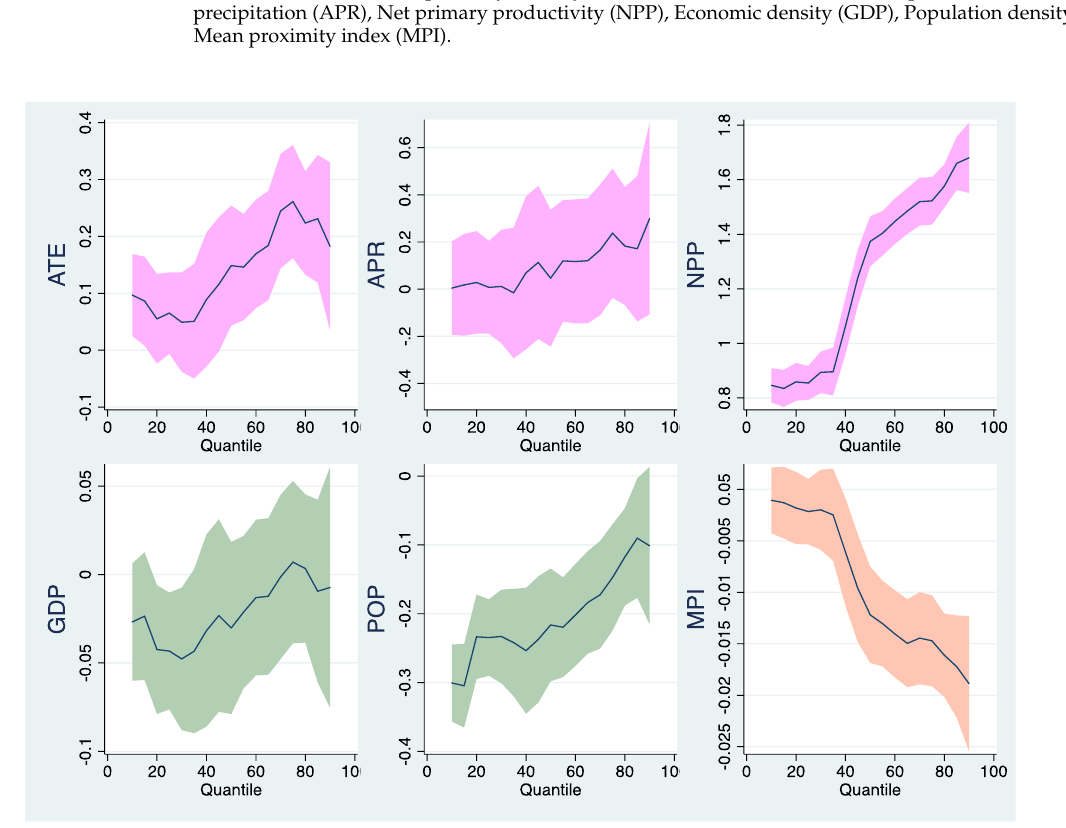
Figure 7. Quantile regression coefficient variation diagram of influencing factors of ESV in SCBJ. Note: Acronyms are defined as Annual mean temperature (ATE), Annual mean precipitation (APR), Net primary productivity (NPP), Economic density (GDP), Population density (POP), and Mean proximity index (MPI).